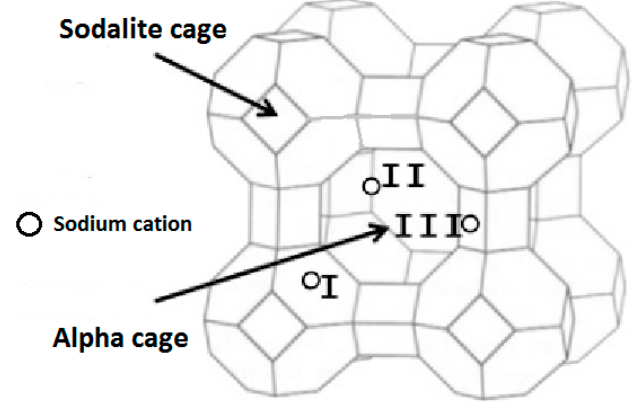
Figure 1. LTA-type zeolite with sodium cations positions.